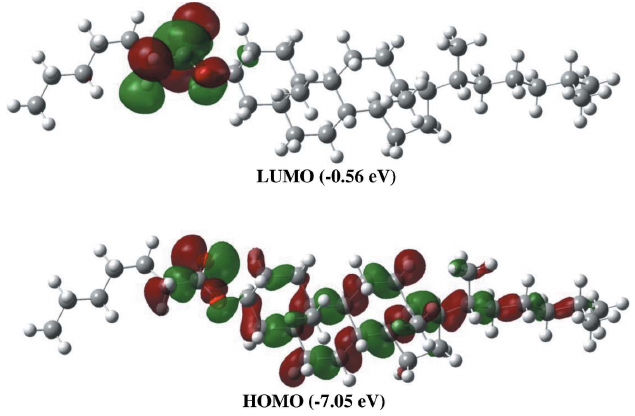
Figure 8 The LUMO and HOMO energies of the title compound,